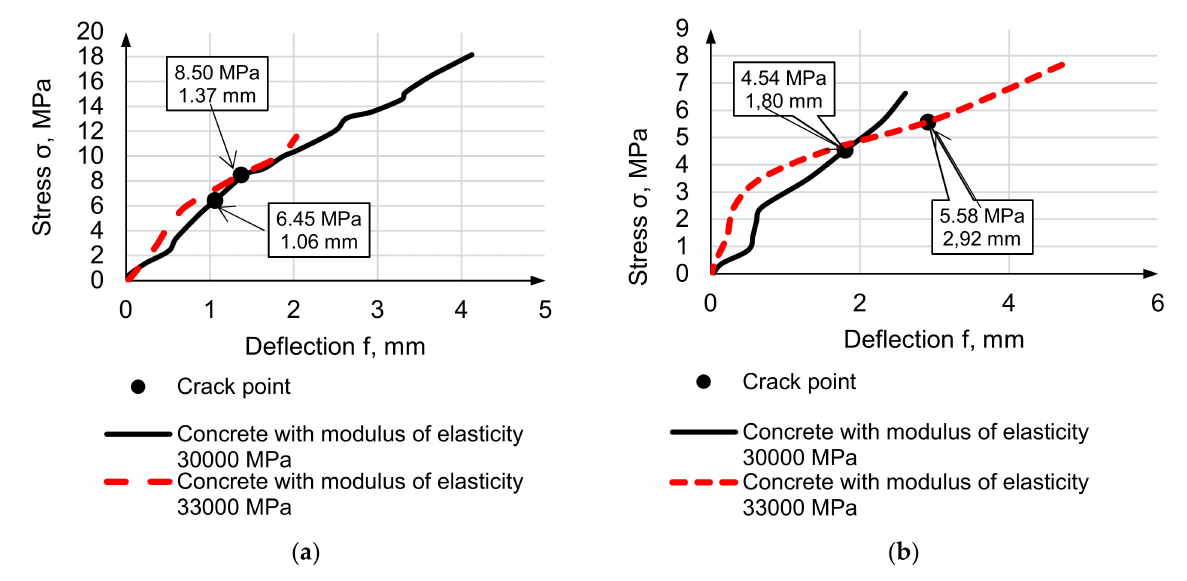
Figure 11. Stress-deflection curves for HWC, reinforced by steel ( a ) and composite ( b ).